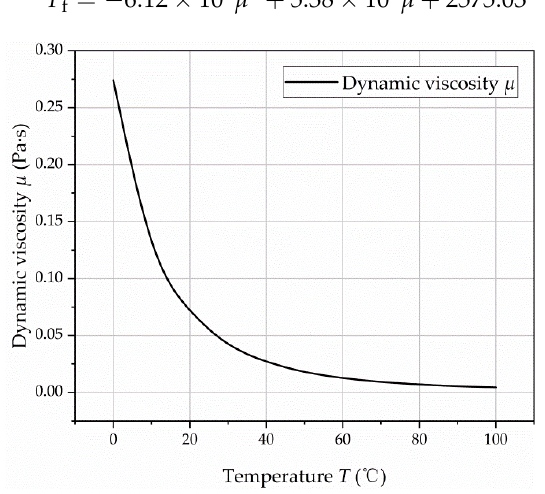
Figure 13. The viscosity of No. 32 hydraulic oil varies with temperature.